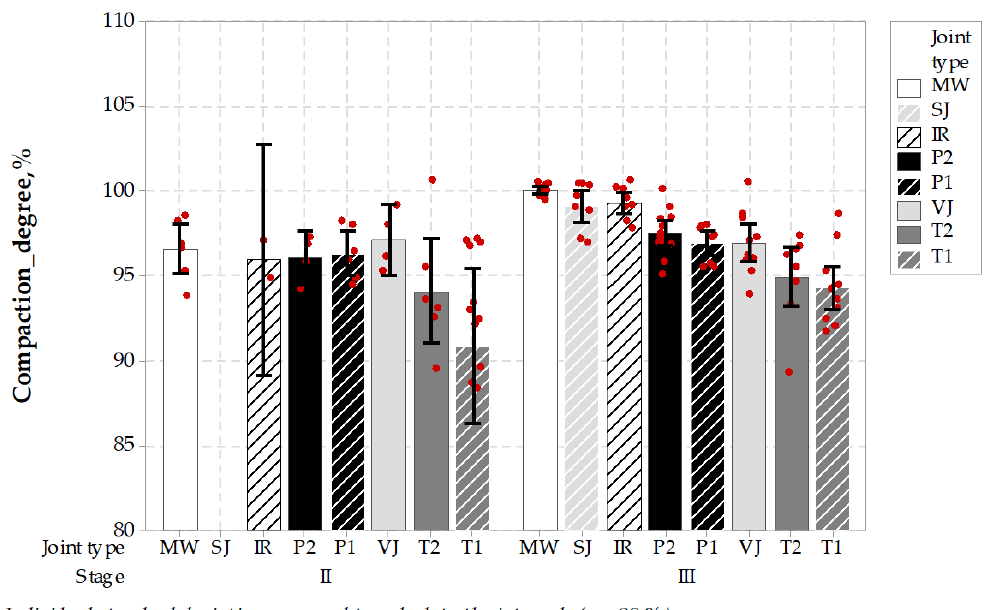
Table 13. Fisher’s pairwise comparison for density test, bulk density SSD, Mg/m 3 .